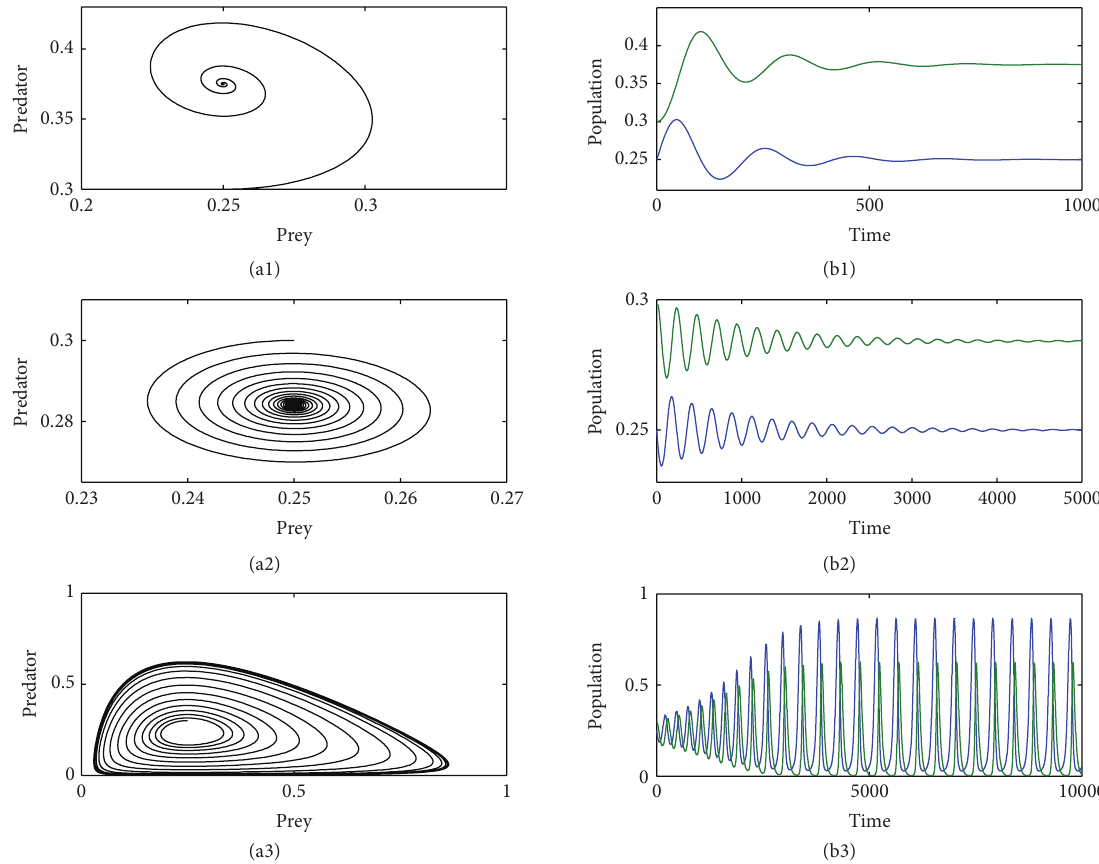
Figure 4: The population dynamics of the prey-predator system with and without Allee effect. ((a1) and (b1)) Without Allee effect, ((a2) and (b2)) predator with Allee effect, and ((a3) and (b3)) prey with Allee effect. All parameter values are the same as Figure 2.